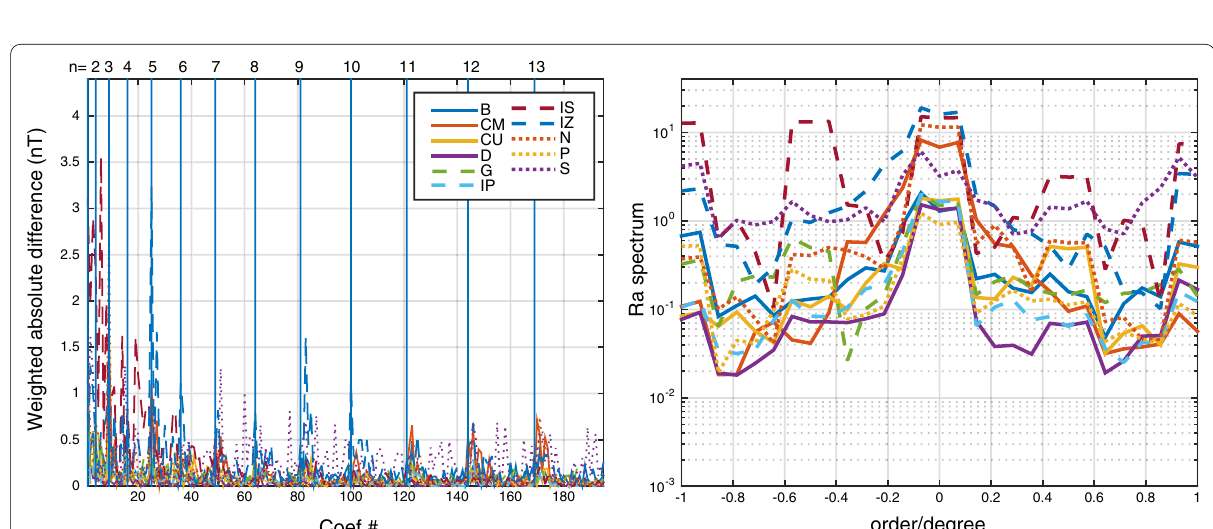
1 (left) and azimuthal power spectrum differences (right) between the +